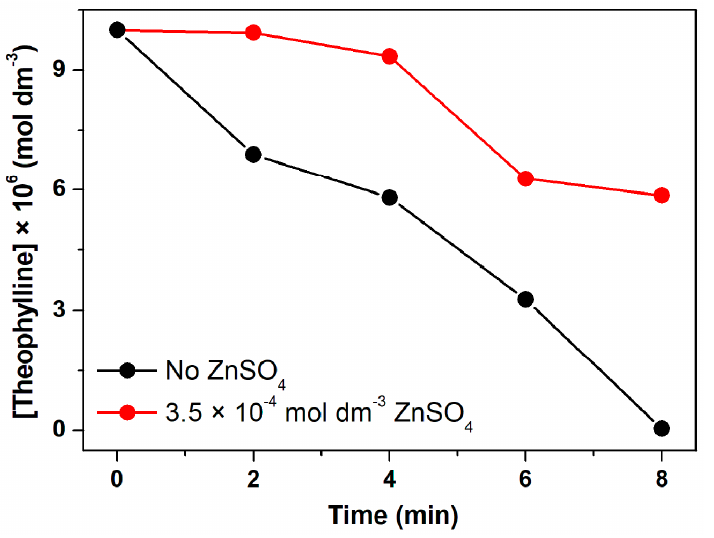
Figure 4. Photo-degradation profile of theophylline (1 × 10 − 5 mol dm − 3 ) in the presence of (black) 5 × 10 − 5 mol dm − 3 H 2 O 2 and in the presence of (red) 3.5 × 10 − 4 mol dm − 3 zinc sulfate.